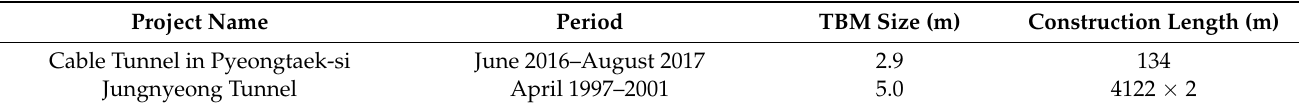
Table 1. Examples of construction projects carried out in South Korea using the TBM and NATM extension blasting